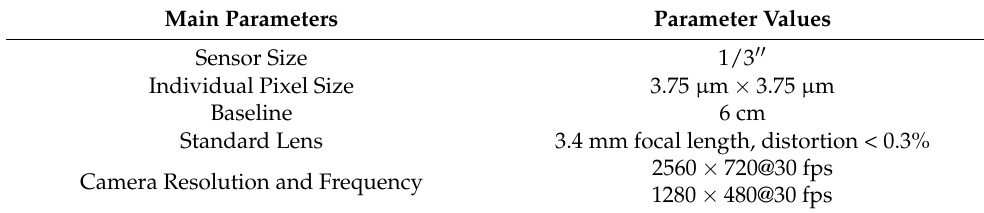
Table 2. Parameters of the camera.